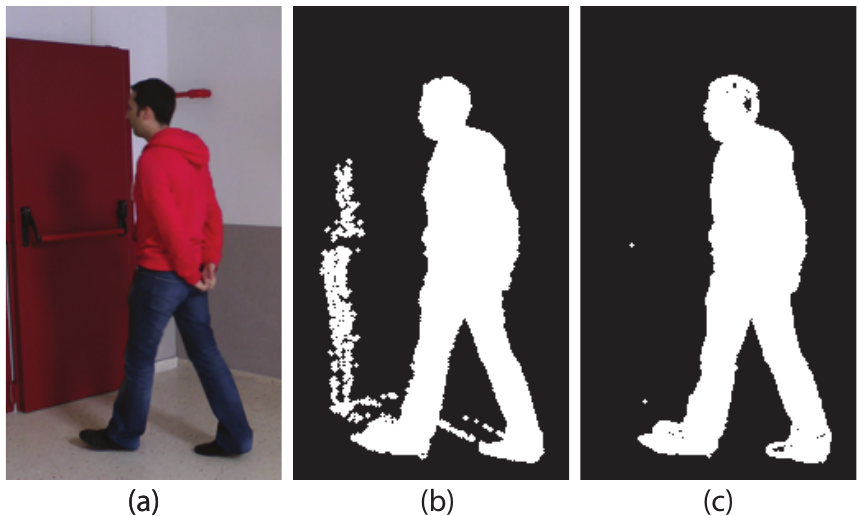
Figure 7. ( a ) Original image; ( b ) detection using RGB color; ( c ) detection using the alternative appearance components ( RnGn | (cid:53) s |